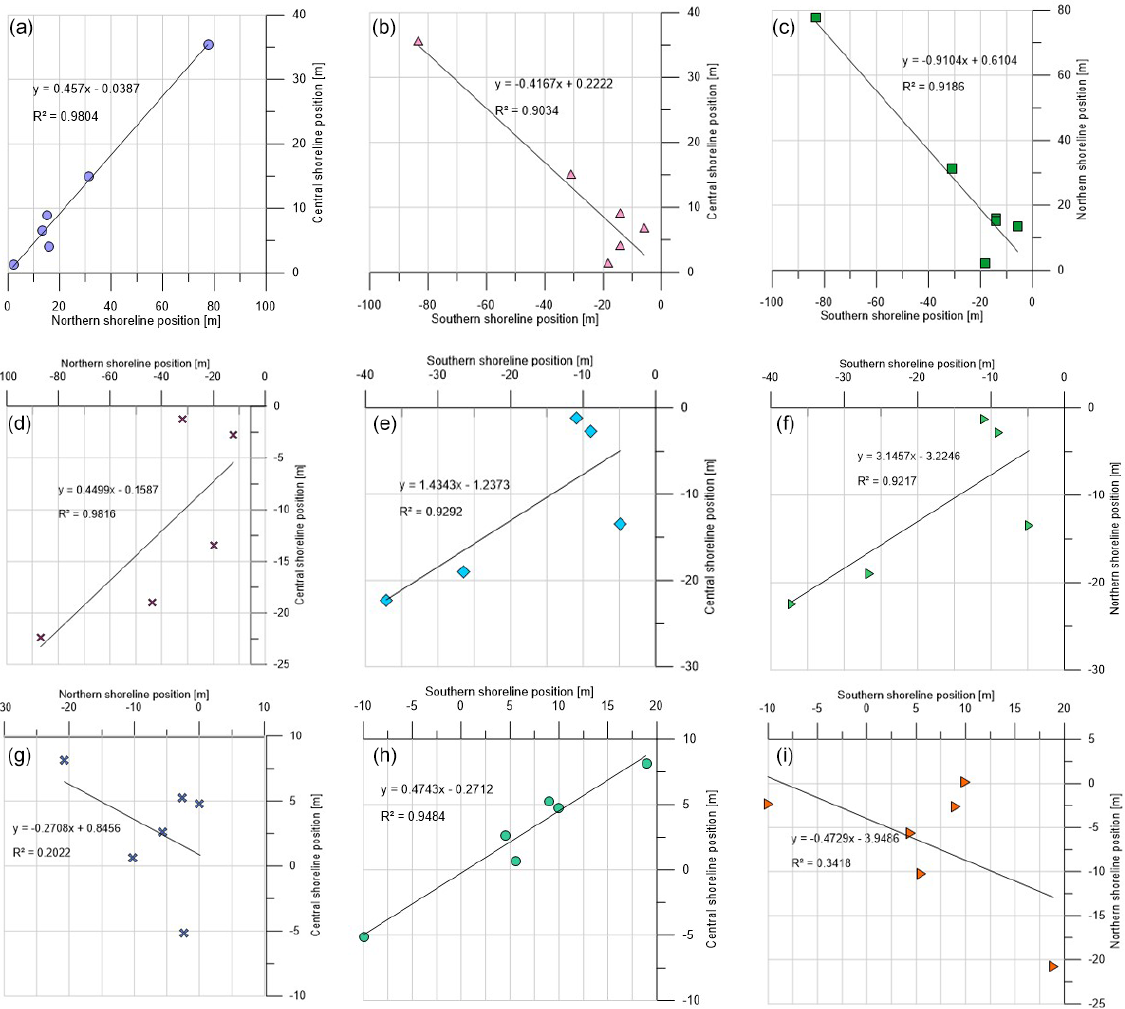
Figure 14. Spatial correlations of the averaged shoreline changes during the investigated period between northern and central shorelines, southern and central shorelines, and southern and northern regions in Cell I (a–c) , Cell II (d–f) and Cell III (g–i) . Table 3. Pearson’s correlation matrix applied to Cell III. Note: red marks positive relationships between profiles and blue marks negative relationships. Italic indicates p < 0 .